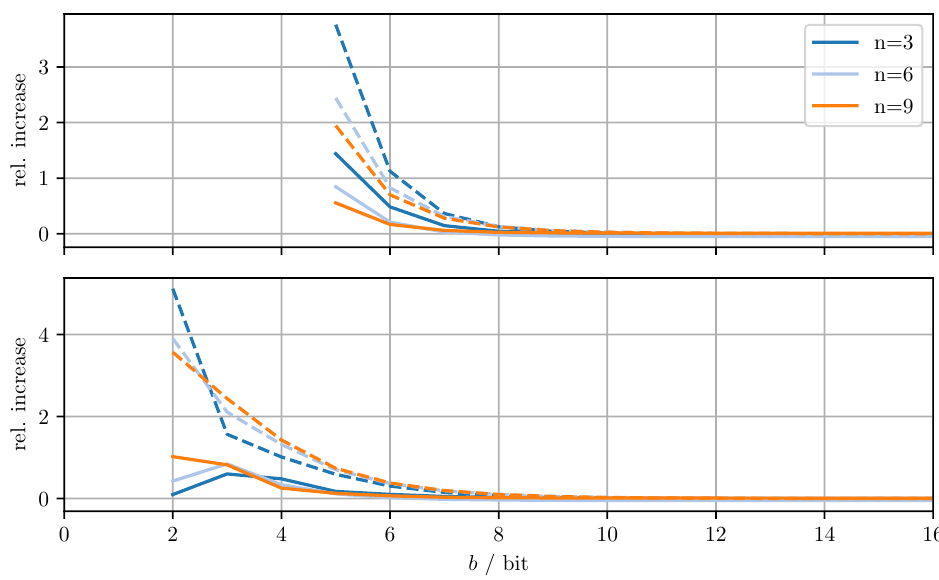
Figure 6. Relative increase of actual MSE (solid)/averaged trace (dashed) of DD-CI with respect to CI for varying dimensions n and bits per codeword b . Top row with quantized estimate vector and quantized error covariance, bottom row only with quantized error covariance.